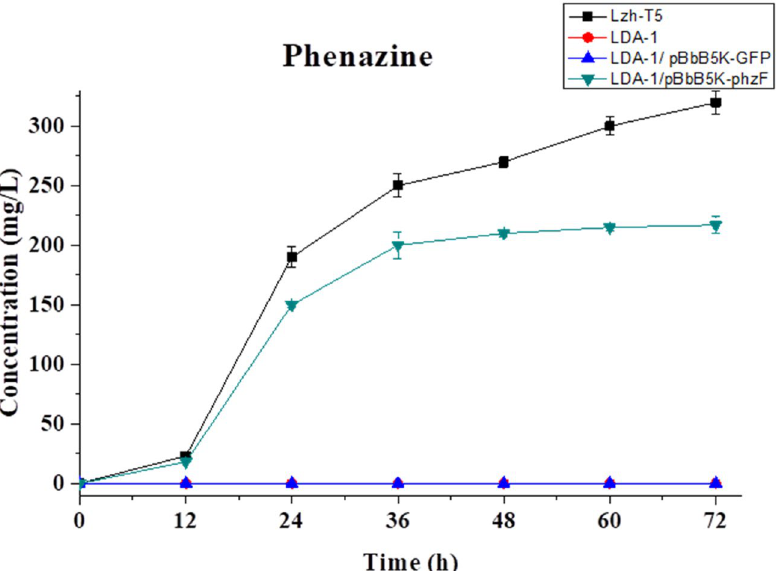
Figure 3. Phenazine production of P. chlororaphis Lzh-T5, LDA-1, LDA-1/pBbB5K-GFP, and LDA-1/pBbB5K- phzF.